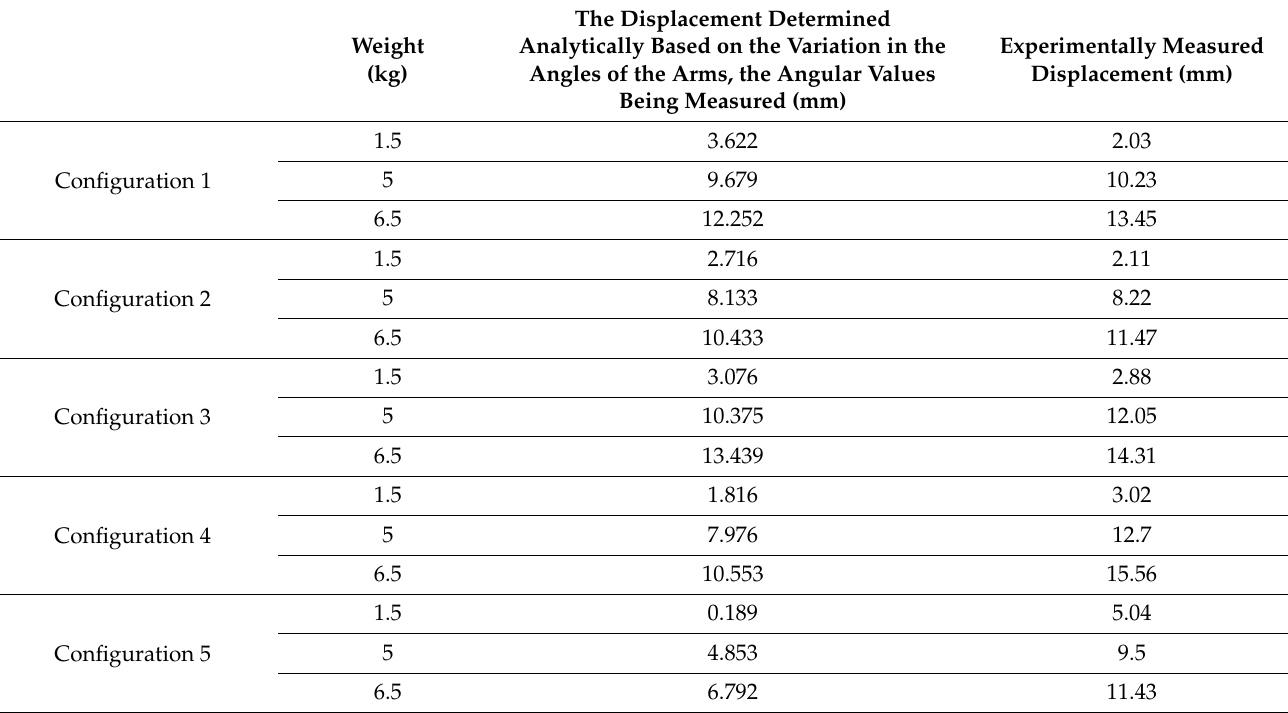
Table 8. Effector displacement calculated on the basis of the axial deformations of the motors, considering them as elastic